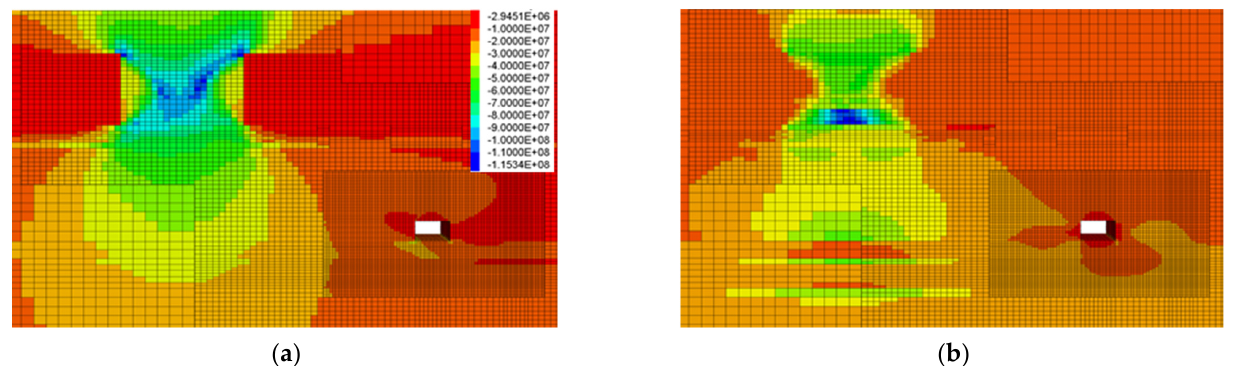
Figure 18. Principal stress distribution contour of the roadway’s surrounding rock when the coal column is 8 m. ( a ) σ 1 cloud. ( b ) σ 3 cloud.